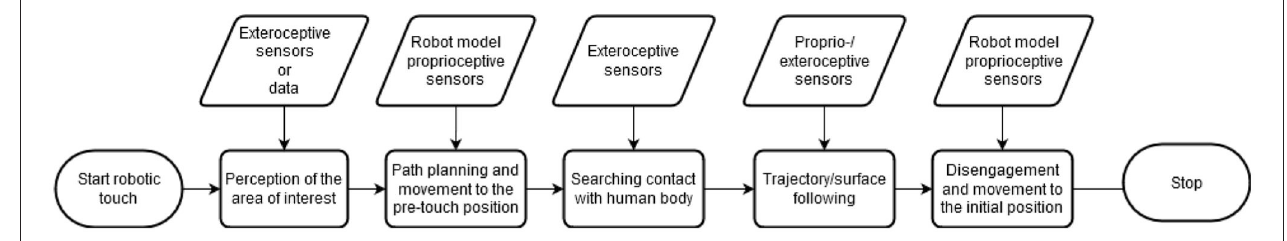
FIGURE 3 | Flow chart of a simplified robotic touch. Steps 2 to 4 are expected to crucially influence the perception of touch and, therefore, its role as safety